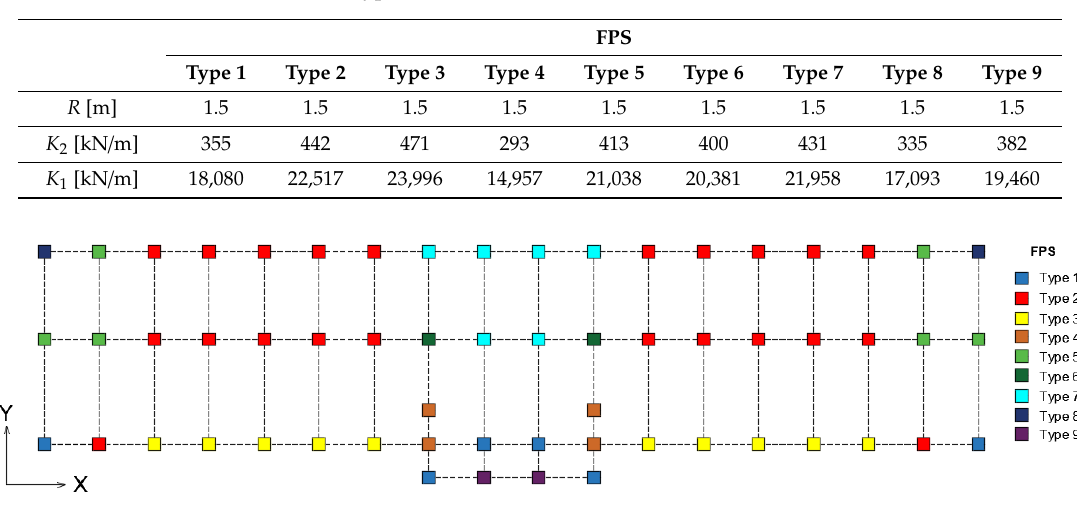
Figure 5. Location of the adopted FP devices in plan.